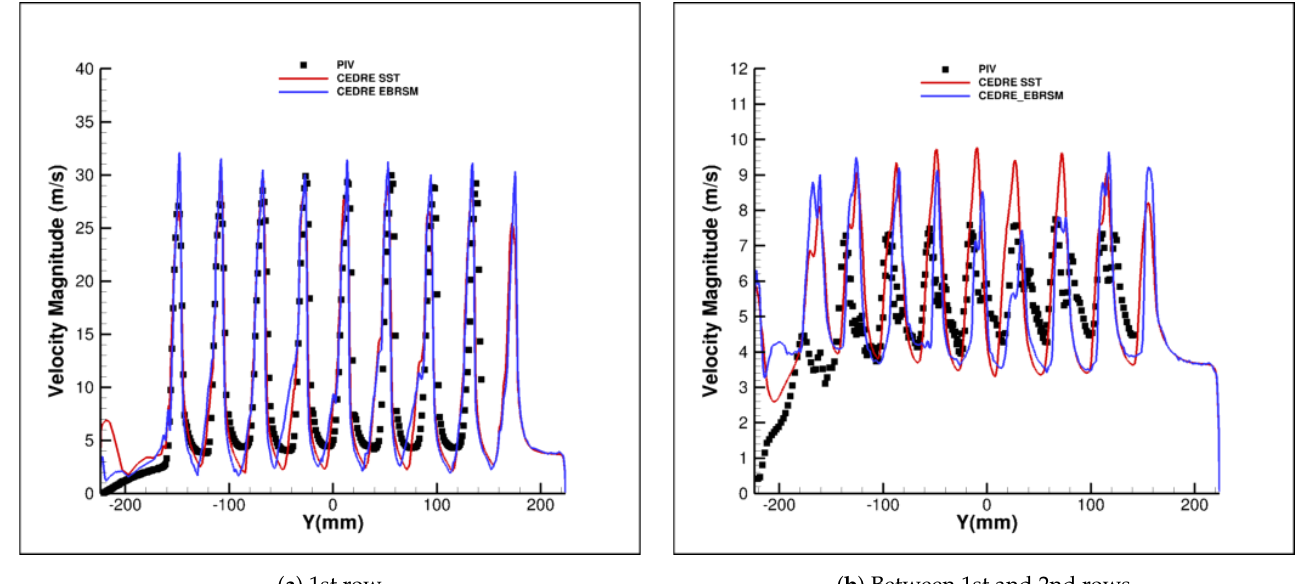
turbulent stresses.